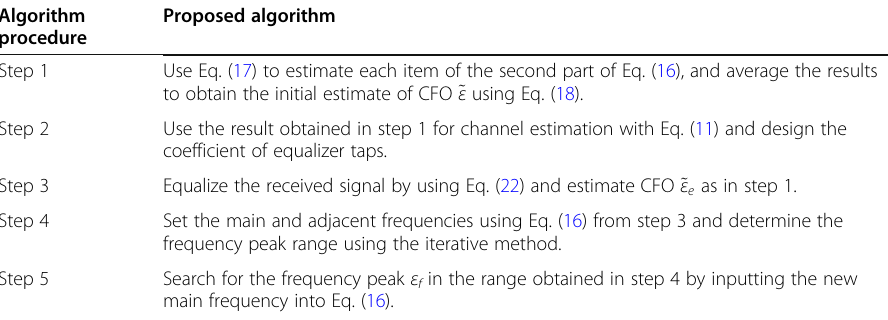
Table 1 Summary of the proposed algorithms Algorithm Proposed algorithm procedure